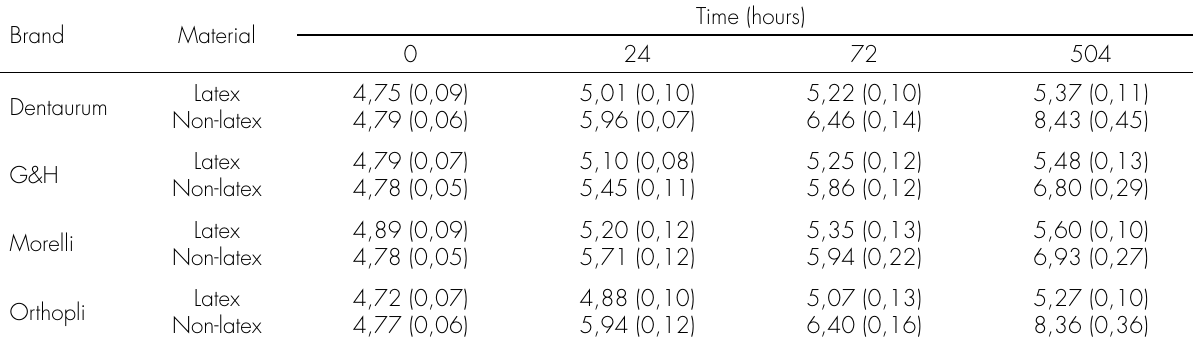
* Values in % Table III. Mean and standard deviation of the internal diameter of the elastic latex and non-latex in evaluated periods. Brand